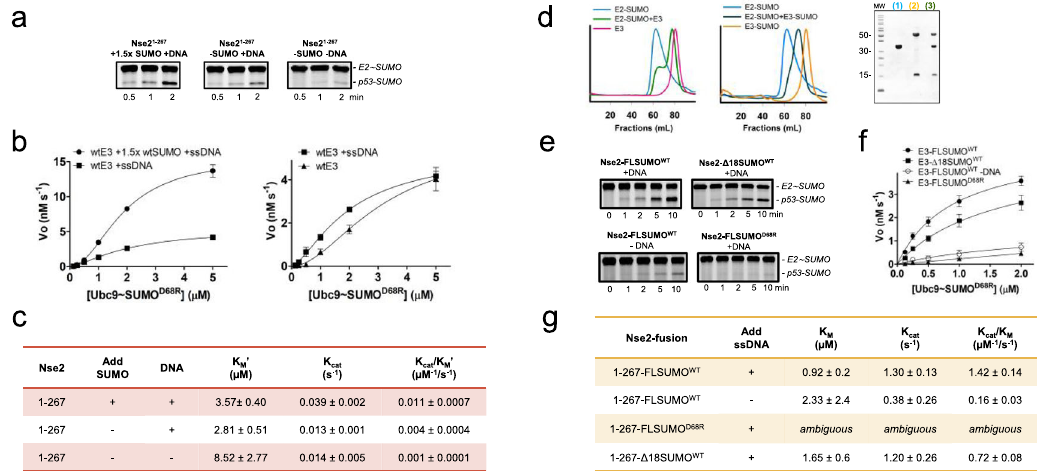
Fig. 5 Effect of SUMO B backside and ssDNA on E3 activity of Nse2-Arm/Smc5. a Representative SDS – PAGE reactions at 1 μ M Ubc9~SUMO D68R – Alexa488 thioester. b Kinetics of single-turnover reactions using puri fi ed E2Ubc9~SUMO D68R – Alexa488 thioester, ±1.5-fold excess of non-conjugatable SUMO B , ±50nt ssDNA, c p53, and non-fusion E3 (400 nM) at 30°C. c Kinetics parameters were obtained using Hilll ’ s sigmoidal equation in Prism (GraphPad). The quanti fi ed rate data show mean ± s.d. ( n = 3 technical replicates). For gel source data, see Supplementary Fig. 4. d Gel fi ltration chromatography and SDS-PAGE of Nse2 and Nse2-SUMO fused in complex with Ubc9-SUMO D thioester mimetic. e Representative SDS – PAGE reactions at 1 μ M E2Ubc9~SUMO D68R – Alexa488 thioester. f Kinetics of single-turnover reactions using puri fi ed E2Ubc9~Smt3 D68R – Alexa488 thioester, ±50nt ssDNA, c p53, and indicated fusion E3-SUMO (4 nM) at 30°C. g Kinetic parameters were obtained using M-Menten ’ s equation in Prism (GraphPad) are shown. The quanti fi ed rate data show mean ± SD ( n = 3 technical replicates). For gel source data, see Supplementary Fig. 5 and Source Data fi